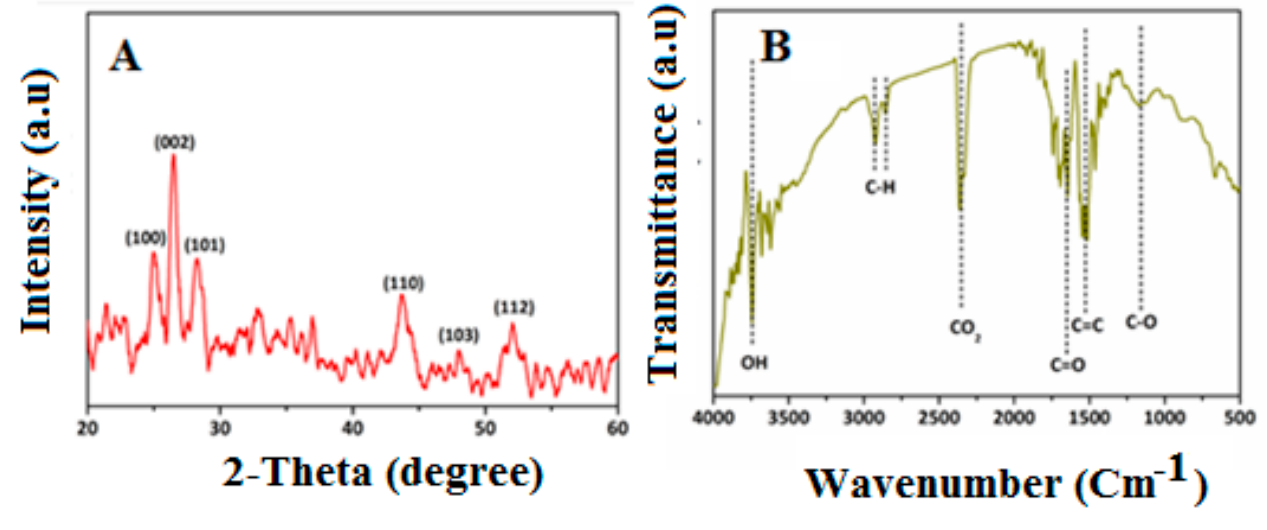
Figure 4. ( A ) XRD pattern and ( B ) FTIR spectra of CdS-GO nanocomposite.